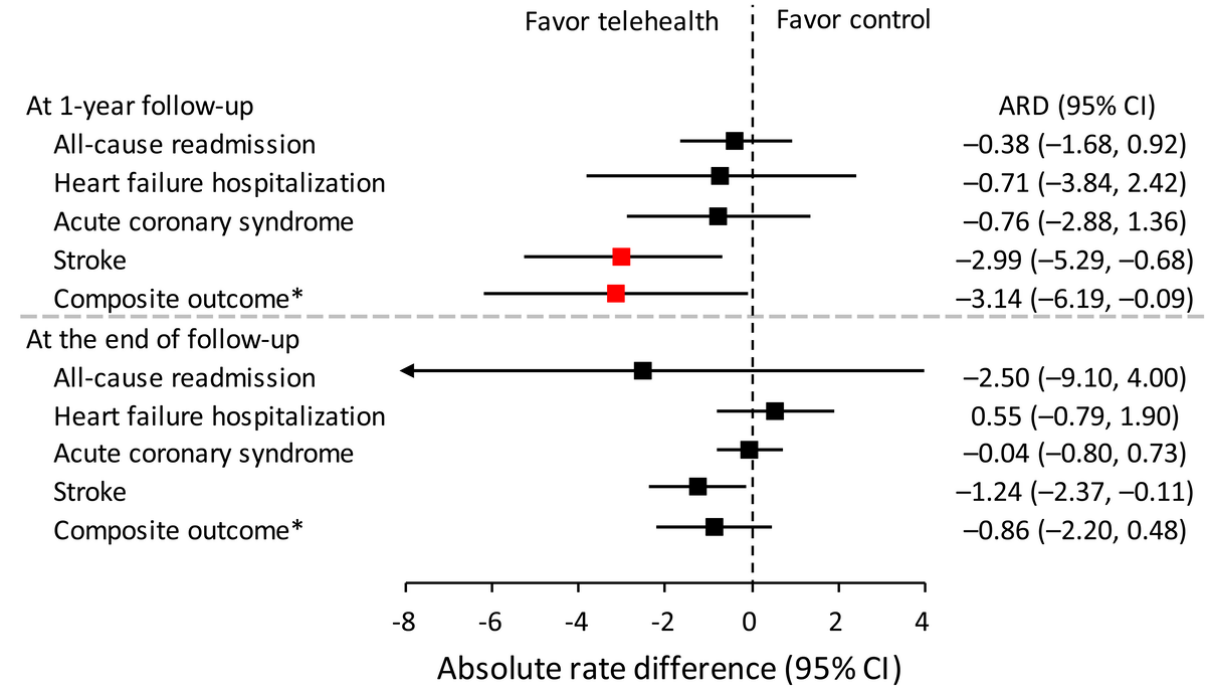
Figure 4. The difference of the incidence rate (expressed as number of event per 100 person-years) of all outcomes in patients who participated in the telemedicine program and who did not participate in the inverse probability of treatment weighting–adjusted cohort. ACS: acute coronary syndrome; ARD: absolute risk difference. *Composite of ACS and